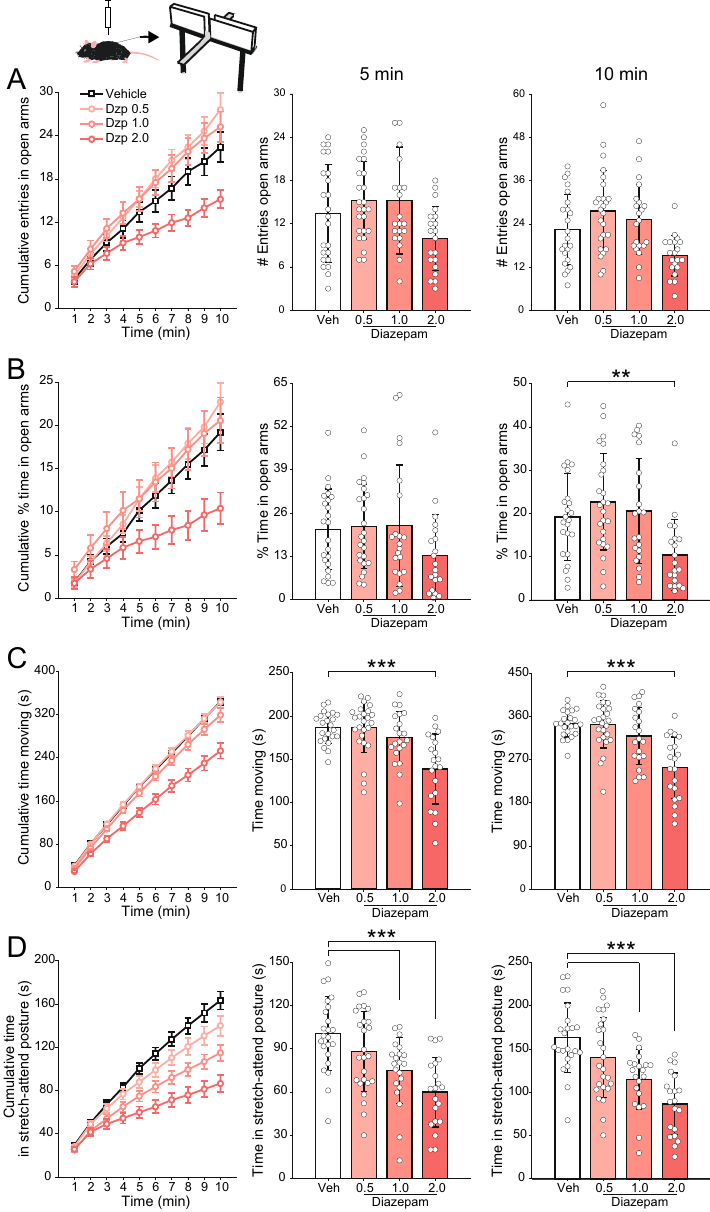
Figure 1. Lack of anxiolytic effect of diazepam in the elevated plus maze. ( A ) (Left) Cumulative number of entries in the open arms along the 10-min session. (Middle and right) Mean (± SD) number of open arm entries after 5 (middle) and 10 min (right). White circles show data for individual animals. Animals were injected i.p. with vehicle or three doses of diazepam (0.5, 1.0 and 2.0 mg/kg) thirty minutes prior to behavior testing, as labeled. ( B – D ) Panels show the same as in ( A ), but for the percentage of the time spent in the open arms ( B ), and the total time animals spent moving ( C ) or in stretch-attend posture ( D ). No anxiolytic effect of diazepam is found in any of the doses, as inferred by no increase in the metrics shown in ( A ) and ( B ) (on the contrary, the highest diazepam dose decreased open arm exploration). Notice further that diazepam induces both a reduction in locomotor activity ( C ) and risk assessment behaviors ( D ). **p < 0.001, ***p < 0.0001, one-way ANOVA followed by Tukey’s post hoc